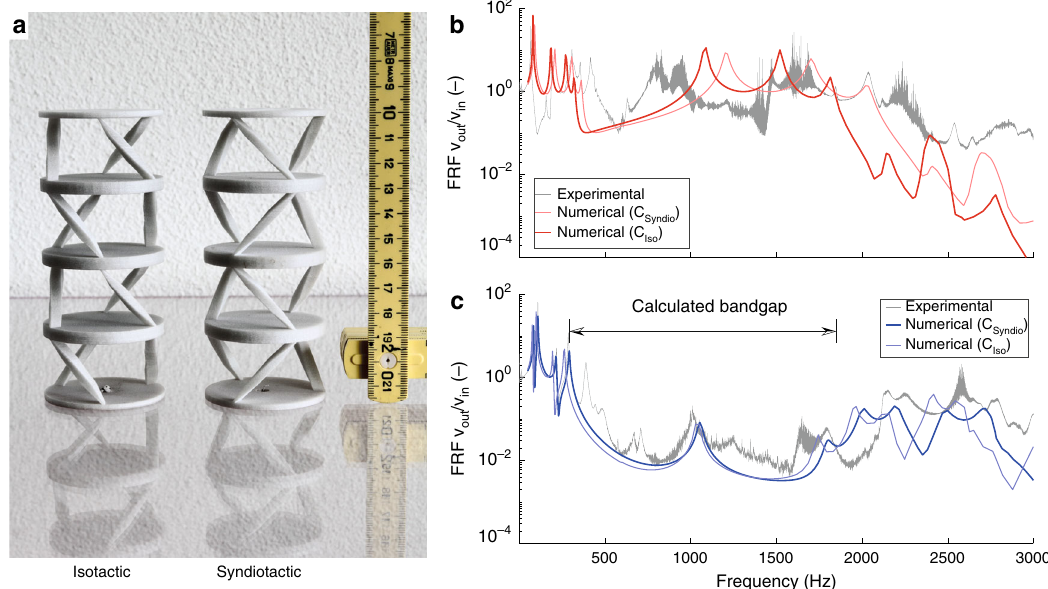
Fig. 1 Measured and calculated transmission spectra. a Photograph of the investigated chiral phononic crystals. Isotactic sample on the left, syndiotactic on the right, with a cm scale, for reference. b Calculated (red) and measured (gray) transmission spectra of the isotactic crystal. The transmittance of the isotactic crystal falls below 10 − 1 at frequencies above 2200 Hz (i.e., above the O2 mode). This is due to the band structure of the isotactic crystal (see Fig. 4c) that presents few fl at modes with small gaps in between them. c Calculated (blue) and measured (gray) transmission spectra of the syndiotactic crystal. The clear drop in the transmission can be seen as a direct observation of the numerically predicted bandgaps. It should be noted that a very simple damping model (proportional to the stiffness matrix) has been used for the fi nite element calculation of the transmission curves. Consequently, an attenuation proportional to the frequency is expected. The lines in strong color (dark red, dark blue) refer to the frequency response calculated based on the fi t from the respective crystal, while the light color indicates the curve calculated using the properties obtained from the other crystal. While the position of features moves slightly, the character of the curves does not